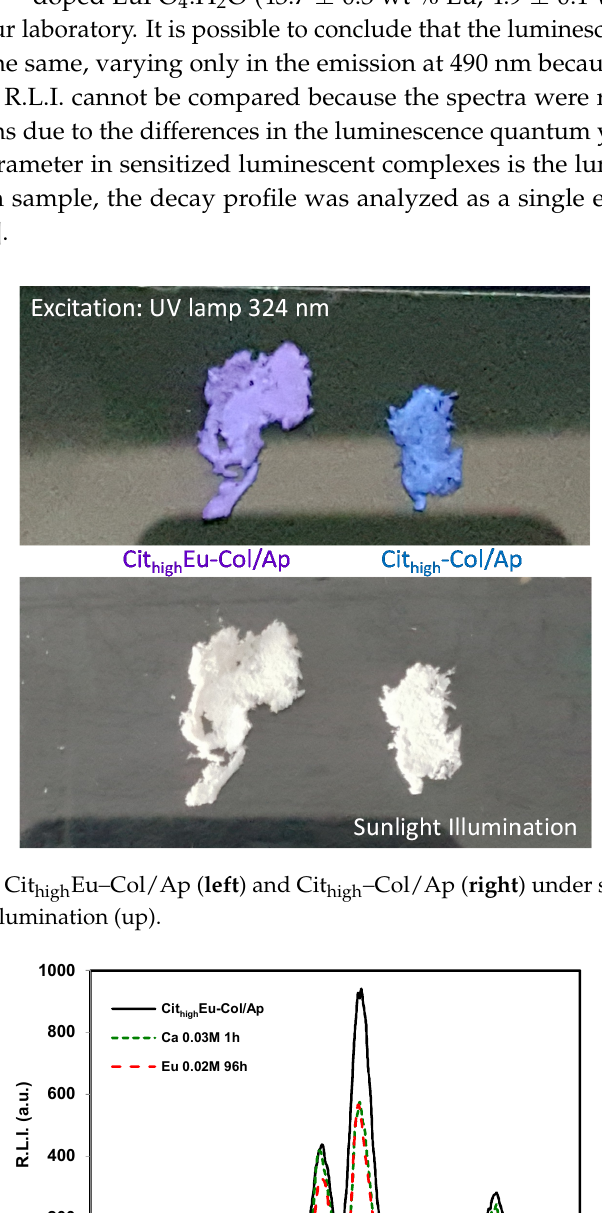
A·e – t⁄τ + C) [52]. Figure 6. Uncorrected emission spectra of Cit high Eu – Col/Ap (solid black line), citrate – coated Eu 3+ – doped carbonated apatite nanoparticles (13.3 ± 2.6 wt % Eu) (dotted green line) and citrate – coated Ca 2+ – doped EuPO 4 .H 2 O (43.7 ± 0.3 wt % Eu, 4.9 ± 0.1 wt % Ca) nanoparticles (dashed red line). An important parameter in sensitized luminescent complexes is the luminescence lifetime (τ); see Figure 7. For each sample, the decay profile was analyzed as a single exponential component (RLI =